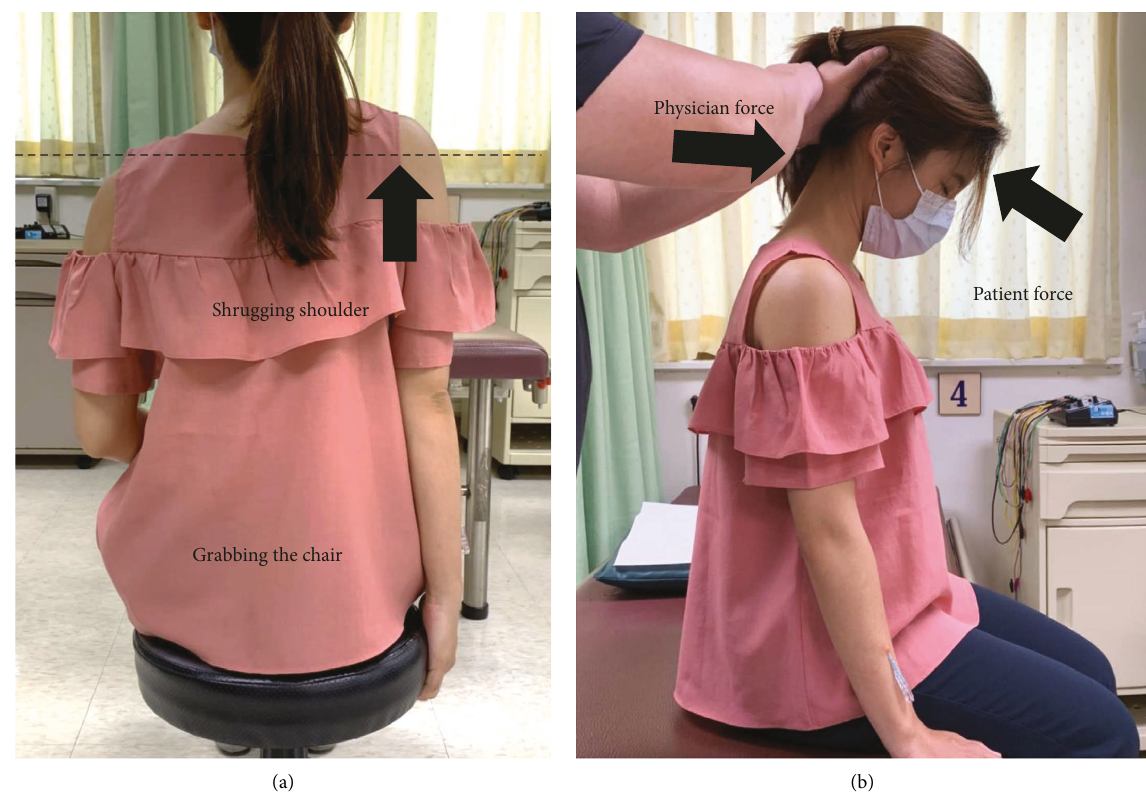
Figure 4: Reperfusion approach of Fu’s subcutaneous needling. The participant was asked to grab the chair and shrug her shoulder on the same affected arm (a) and extend the neck with resistance by the acupuncturist’s push (b) for the contraction of the upper trapezius muscle. The horizontal dashed line indicated the right shoulder